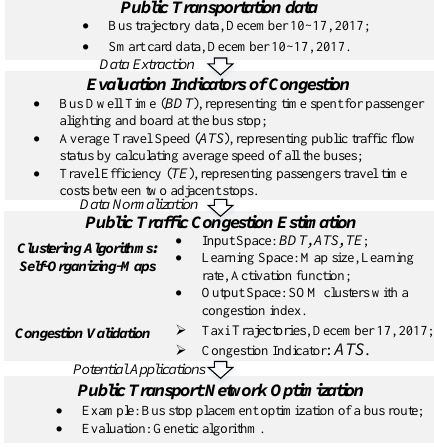
Figure 1. Research